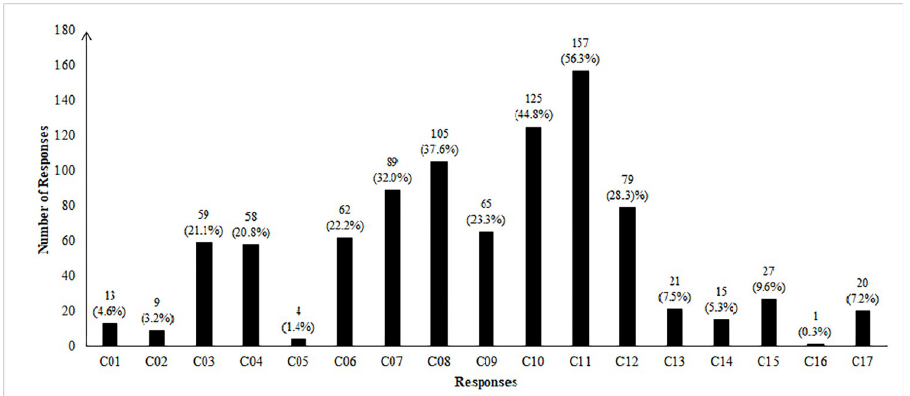
Fig 2. Graphical representation of reasons behind failure to maintain safety guidelines of Covid-19. Table 7 tabulated all the supportive information.